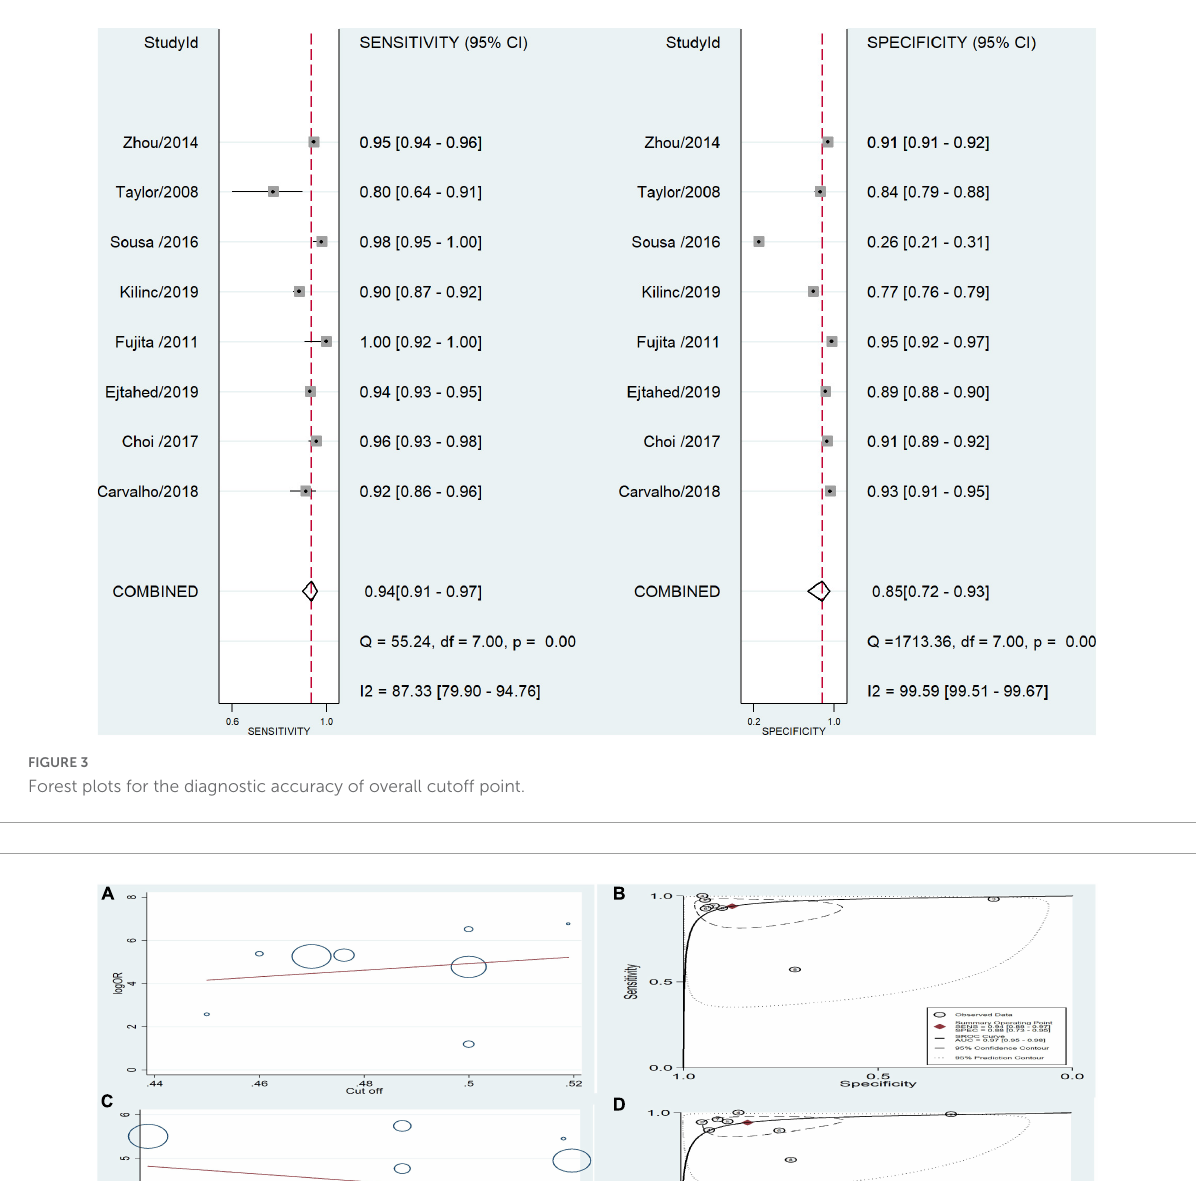
FIGURE4 Diagnostic test accuracy meta-analysis for optimal cutoff score of WHtR for detecting central obesity in children and adolescence. (A) Regression lines of accuracy of WHtR for boys. (B) The optimal cutoff score 0.48 was marked as a cross in the estimated SROC curve. (C) Regression lines of accuracy of WHtR for girls. (D) The optimal cutoff score 0.49 was marked as a cross in the estimated SROC